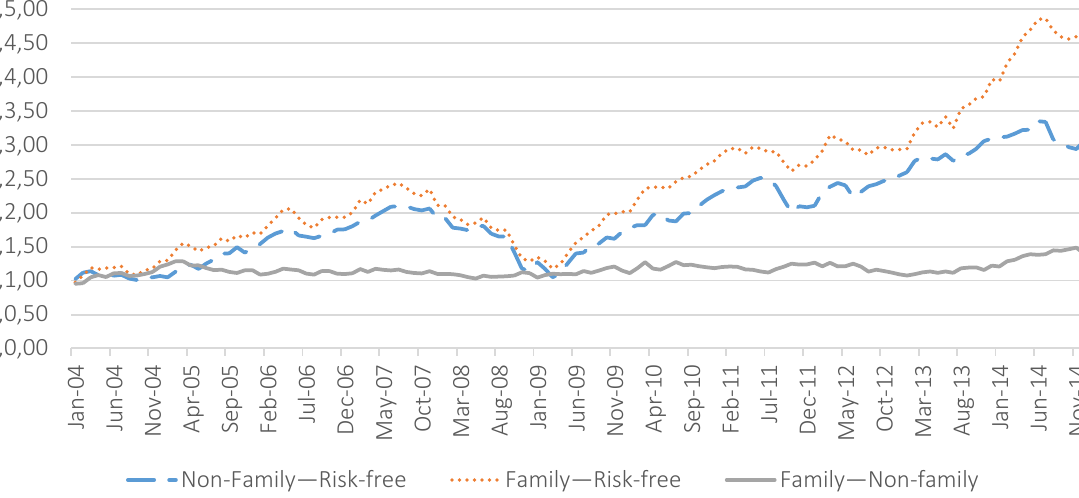
Figure 1. Equally weighted portfolios (buy-and-hold